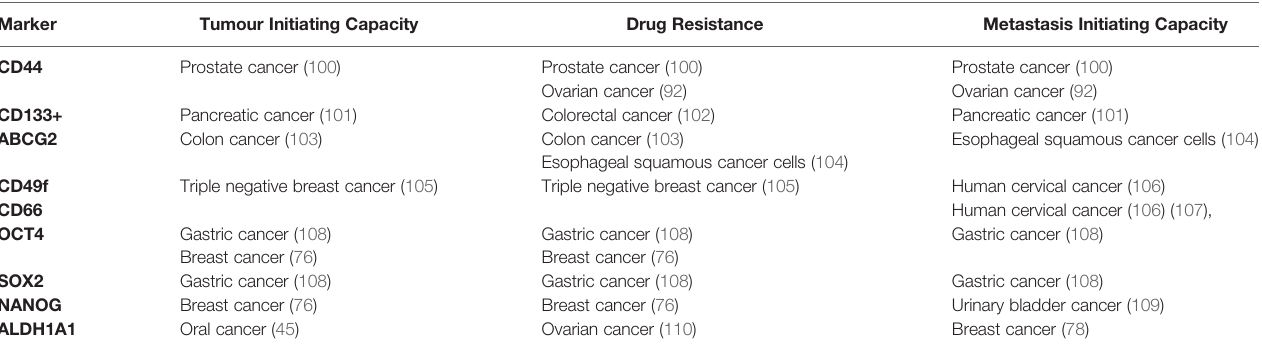
TABLE 3 | Markers of heterogenic